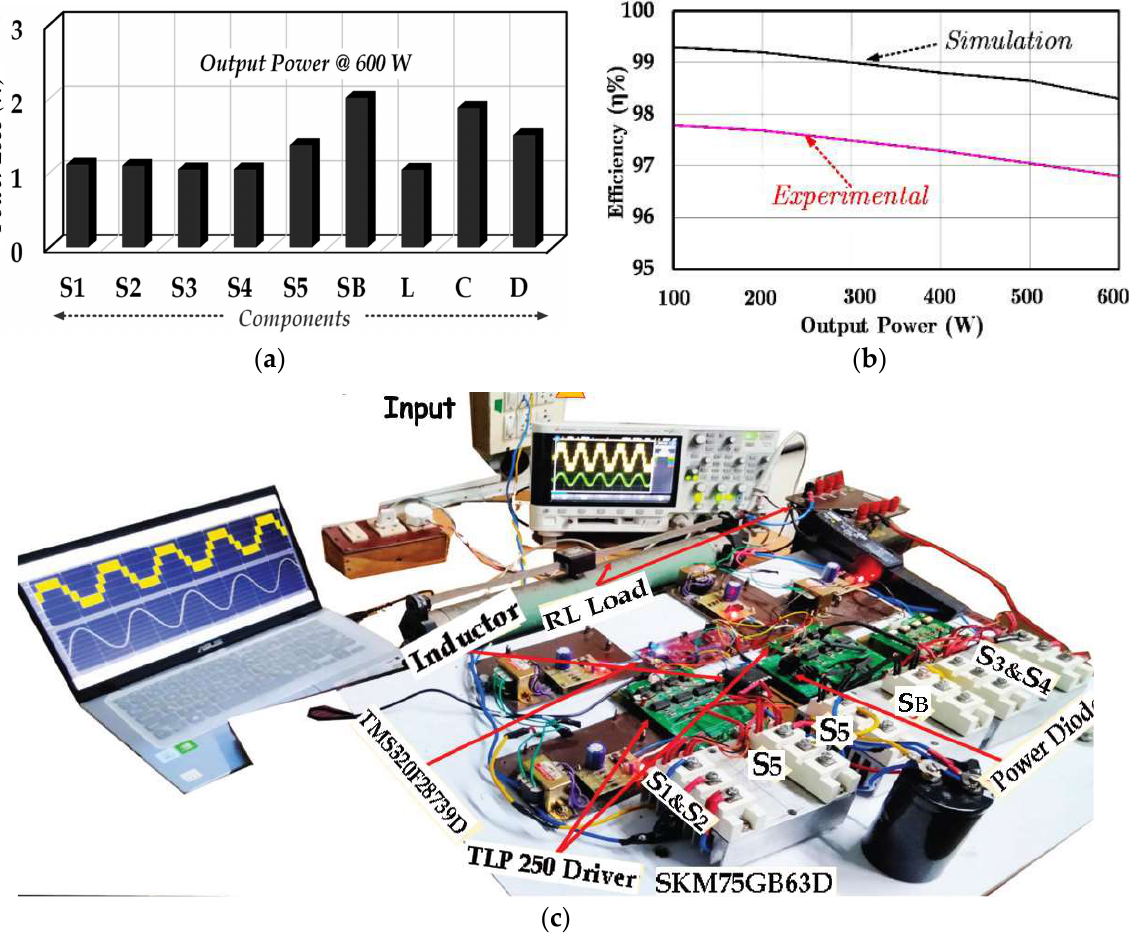
Figure 7. The proposed 5L-SDBI @ 600 W ( a ) power loss distribution, ( b ) the efficiency curve, and ( c ) prototype model. ( S 1 -S 5 , S B —Switches, L/C/D— Inductor/Capacitor/Diode, RL—Resistive -Inductive)